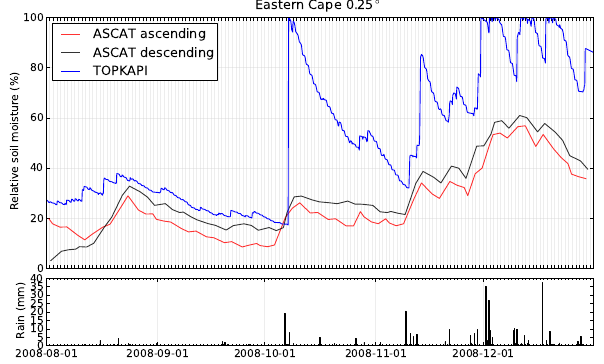
Fig. 13. Site B – Eastern Cape. TOPKAPI and ASCAT derived soil wetness, and TRMM 3B42RT 3h accumulated rainfall. The top panel shows the median TOPKAPI SSI averaged over a 0.25 ◦ block as a blue line. The ASCAT SWI estimates within the box are shown in red/black for the ascending and descending orbits. There is no clear way to choose between the ASCAT ascending and descending passes based on their response to rainfall events. The bottom panel shows a histogram of 3h rainfall accumulations.